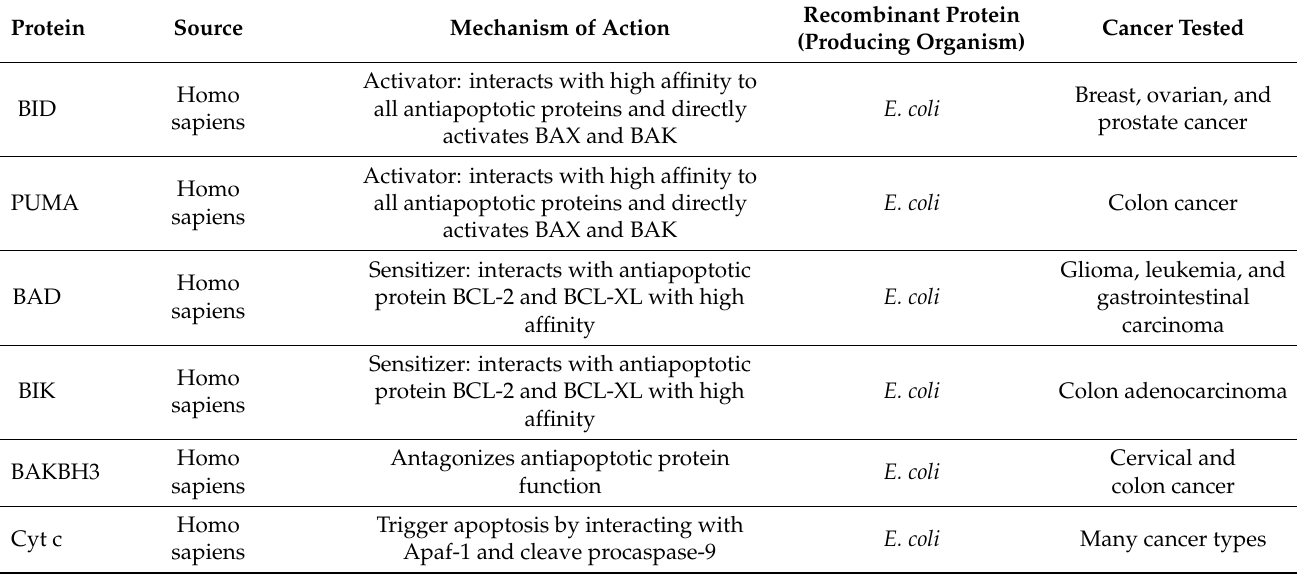
Table 1. Recombinant proapoptotic proteins explored as anticancer drugs. Some content is Reprinted from Trends in Biotechnology, 36, Serna, N.; S á nchez-Garc í a, L.; Unzueta, U.; D í az, R.; V á zquez, E.; Mangues, R.; Villaverde, A., 318–335, Copyright (2018), with permission from Elsevier